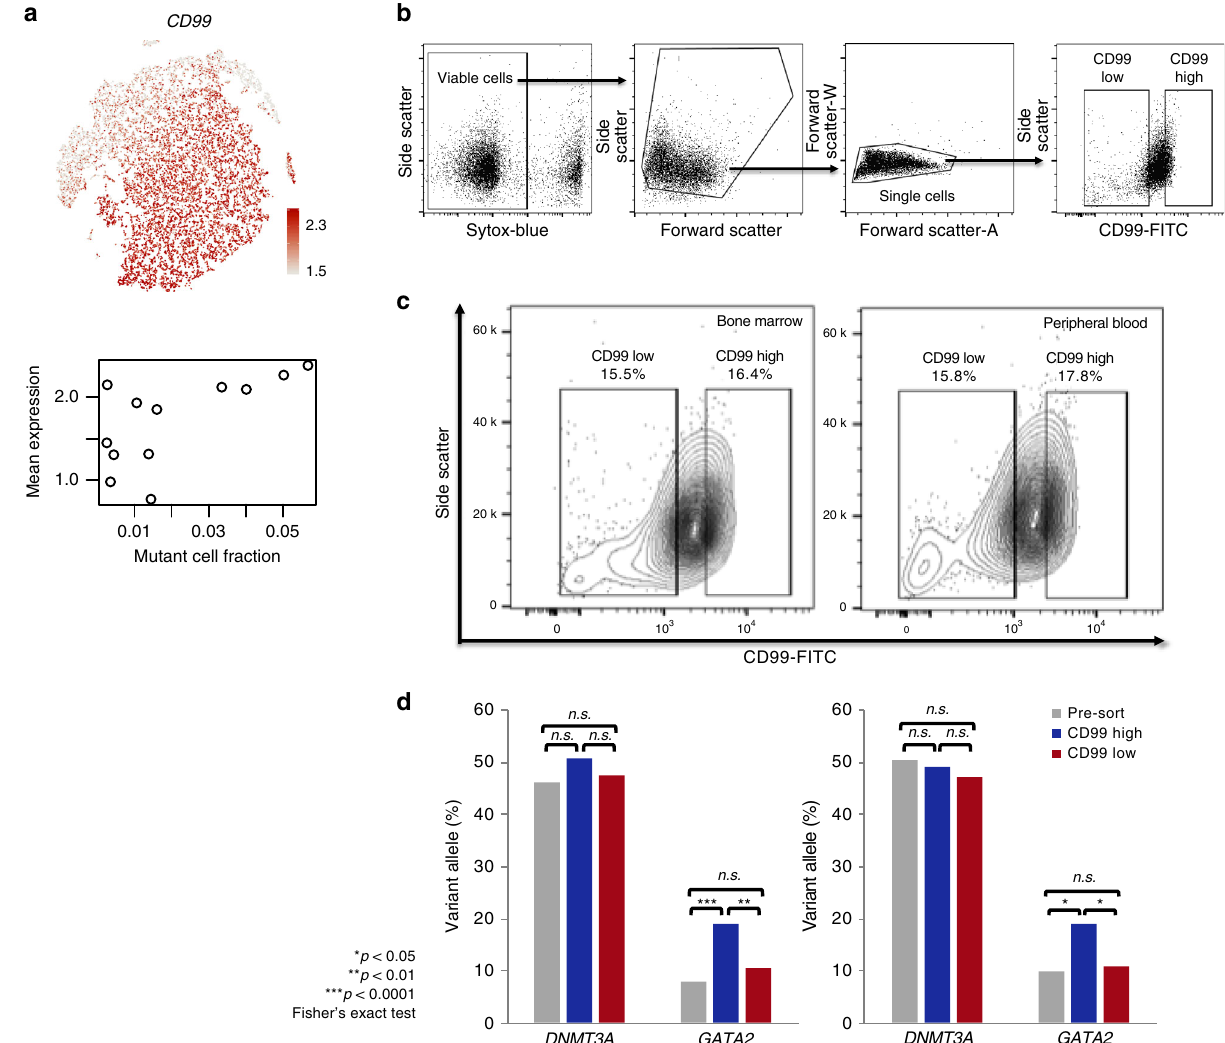
Fig. 6 Orthogonal con fi rmation of GATA2 R361C expression signature by fl ow cytometry and targeted sequencing. a Cells colored according to CD99 expression (top), and scatterplot showing average CD99 expression in each cluster as a function of the GATA2 mutation fraction of each cluster (bottom). b Sorting strategy: Cells staining positive for the dead cell dye Sytox-blue were excluded, then debris was excluded. Singlets were gated for fi nal sorting of CD99-low and CD99-high expressing populations. c Gating of cells based on CD99 expression using fl ow cytometry (bone marrow, left; peripheral blood, right). d Variant allele fraction of the founding clone DNMT3A R882H mutation and the subclonal GATA2 R361C mutation in unsorted cells (gray), CD99-high cells (blue), and CD99-low cells (red) (bone marrow, left; peripheral blood,